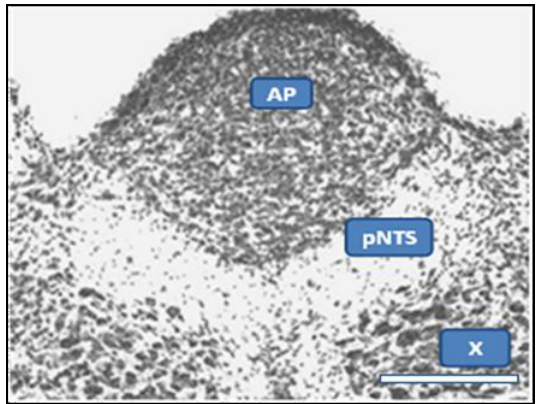
Figure 4. Monosodium Glutamate Effect on the pNTS. This cross section at level of AP from rat given MSG demonstrates preservation of neural elements in the AP and dorsal motor nucleus of the vagus (X), in contrast to total obliteration in the region below AP which corresponds to pNTS. The scale bar at the lower right is 400 microns. Photo from [56], by permission of Literatura Medica,